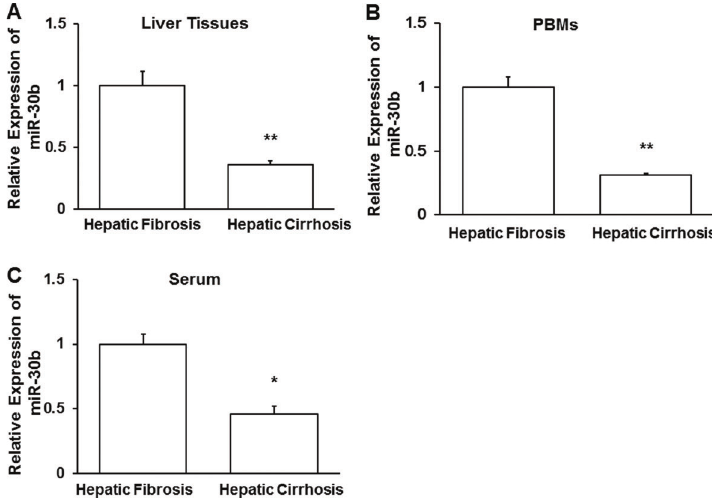
Figure 5. Real-time PCR analysis of miR-30b expression in A , liver tissues, B , peripheral blood monocytes (PBMs), and C , serum from hepatitis B patients with liver fi brosis or liver cirrhosis. Data are reported as means ± SD. *P o 0.05 and **P o 0.01, one-way